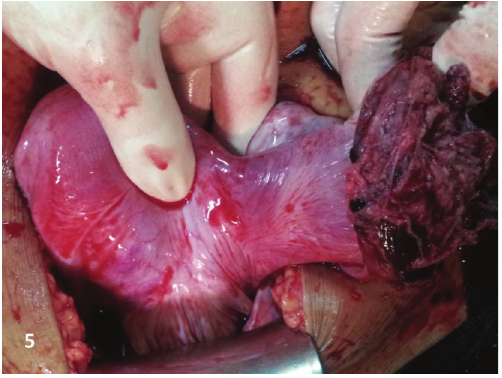
Figure 5: Unicornuate uterus with rupture of rudimentary horn, previous cesarean scar